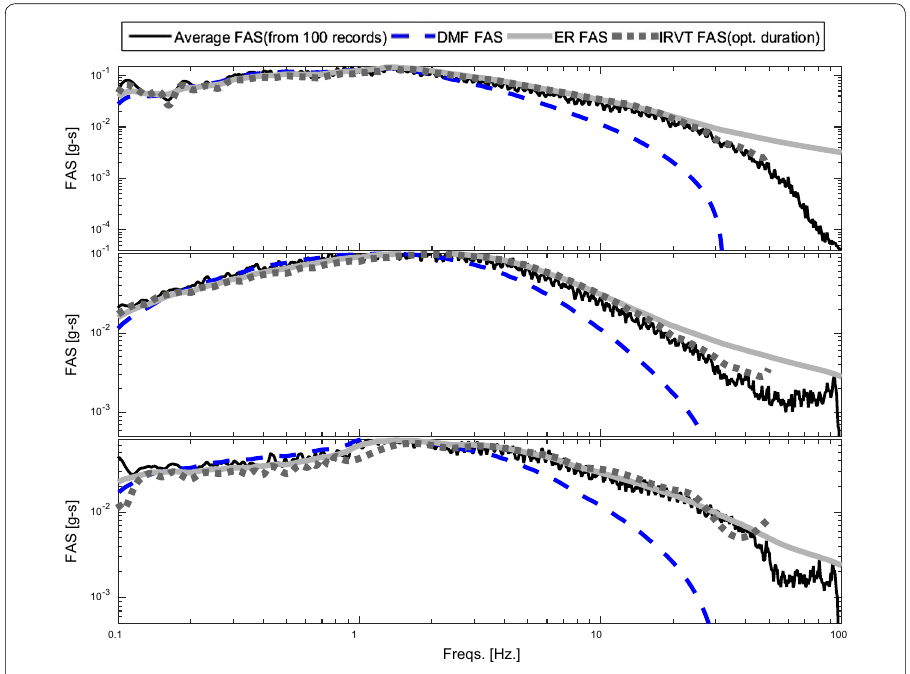
Fig. 5 Spectrum compatible input FAS obtained using the 4 different approaches. Top to bottom: results corresponding to the NRC, NGA and NUC spectra